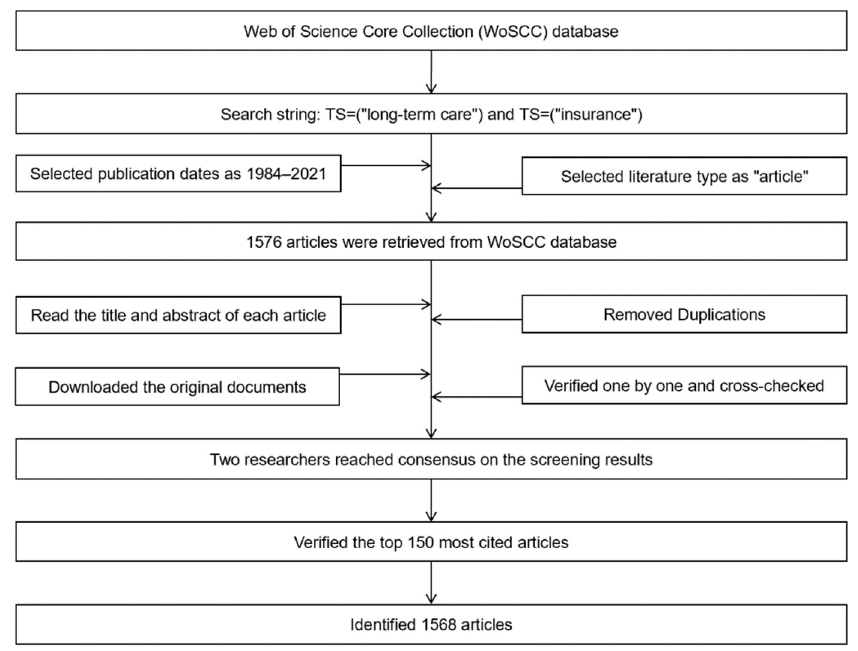
Figure 1. The process of data collection.